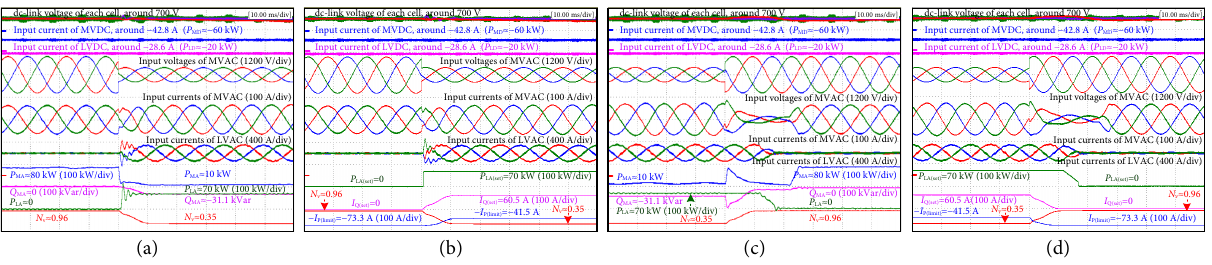
Fig. 22 Experimental results of LVRT Mode-5 in Case-4 of active-power configuration. (a) Real-time power curve in the voltage sag process. (b) Power command curve in the voltage sag process. (c) Real-time power curve in the voltage recovery process. (d) Power command curve in the voltage recovery